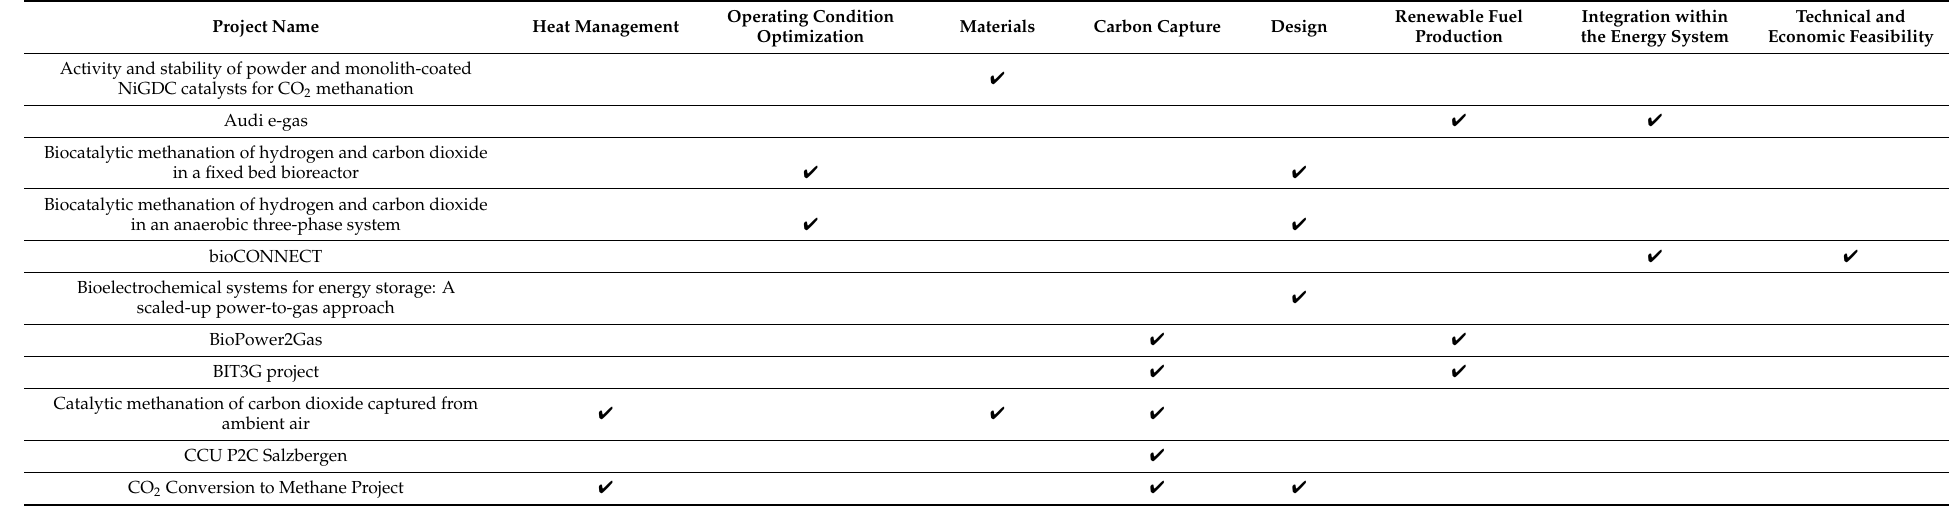
Table A2. Research targets of the selected